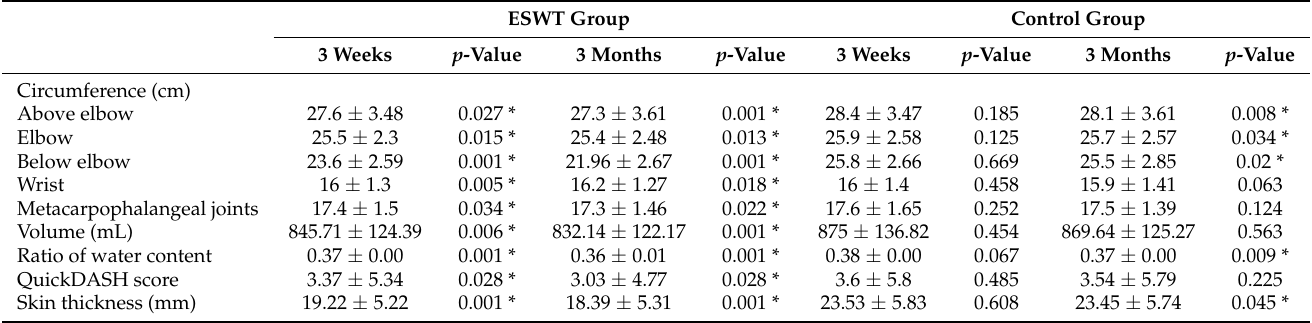
Table 2. Comparison between pre-treatment and post-treatment measurements in both